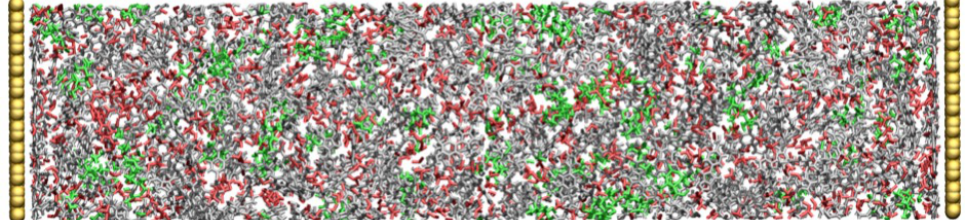
Figure 2. The supercapacitor model after the completion of the polymerisation procedure. Colour scheme: grey, red, green and yellow are for cation, anion, hardener and graphene electrode,